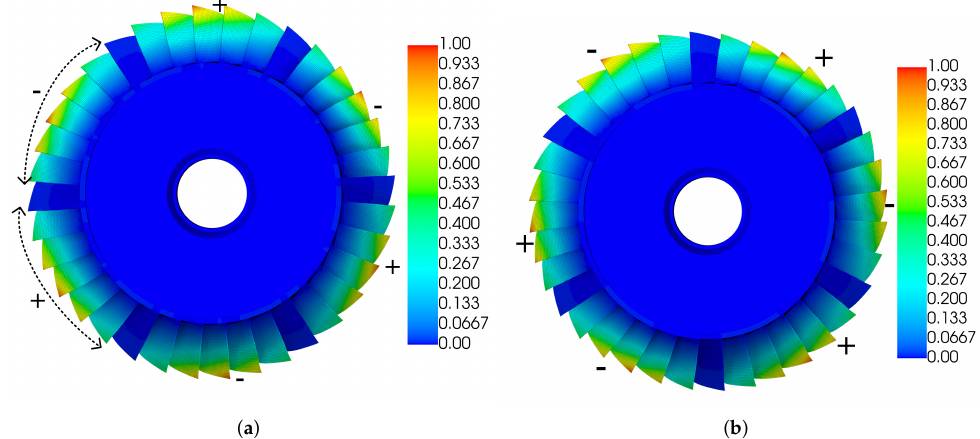
Figure 3. A pair of double-root modal shapes of the first modal family. The colour represents the absolute value of the overall displacement (to highlight nodal diameters). The areas marked by ‘ − ’ are out-of-phase with the areas marked by ’+’. ( a ) NDI = 3, ( b ) the repeated mode, NDI =